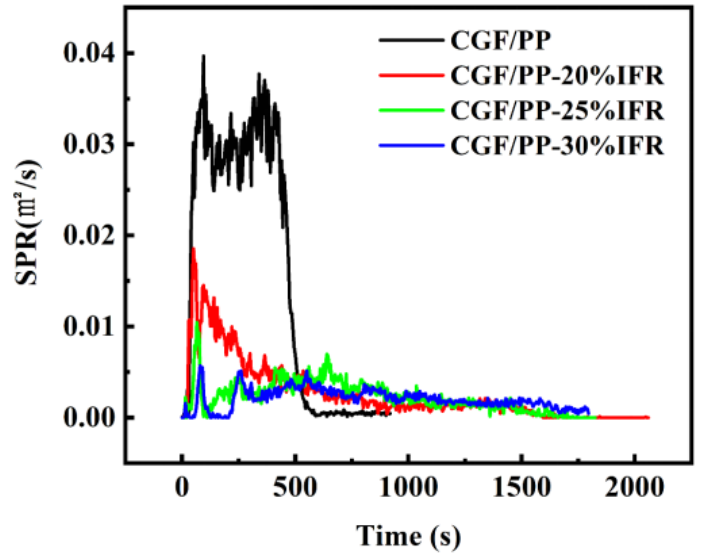
Figure 7. Smoke production rate curves of composites with different IFR content.